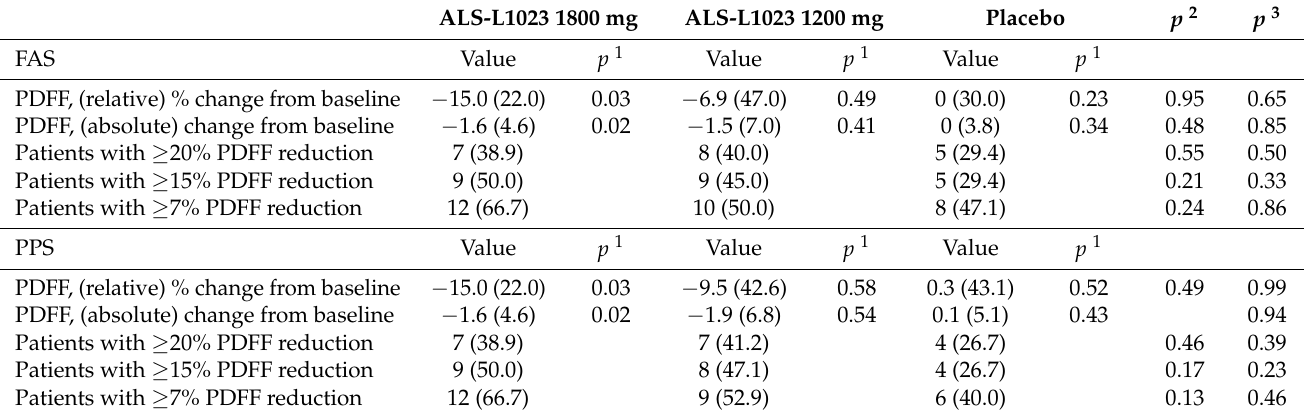
Figure 2. MRI-PDFF change in the FAS. MRI-PDFF results relative mean fat reduction percent from baseline ( A ), and absolute amount of fat reduction ( B ) as determined by MRI-PDFF at week 24. Table 2. Change in MRI-proton density fat fraction from baseline to week 24.